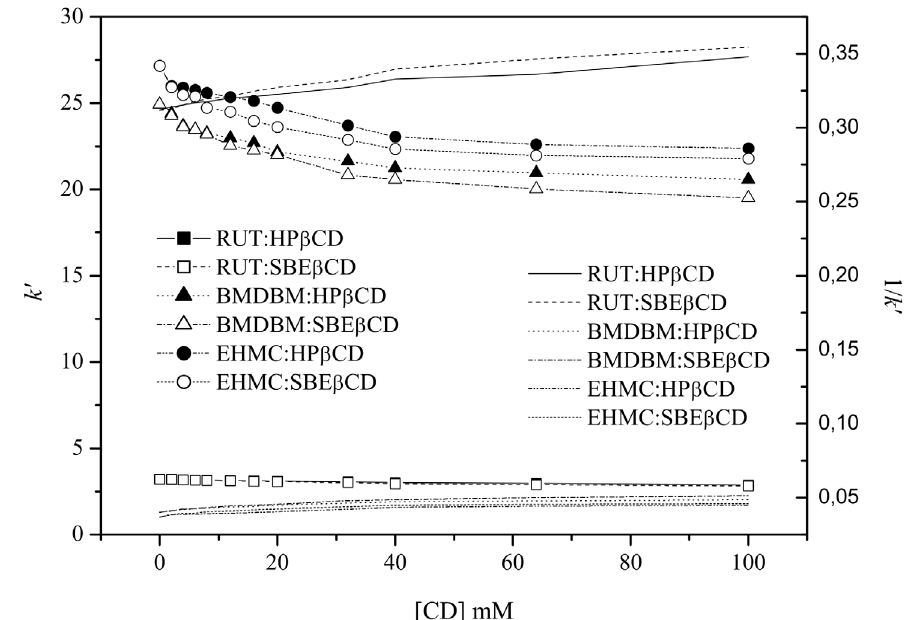
methanol-water (88:12, v/v) at